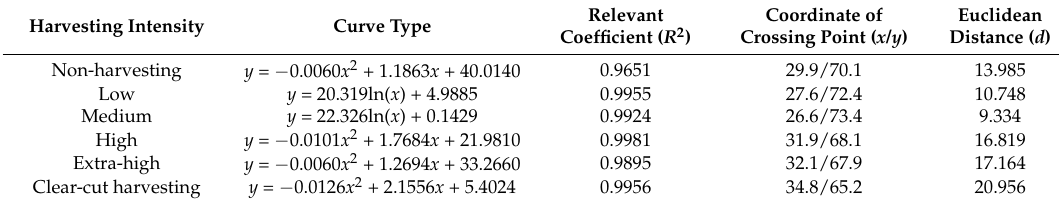
Table 8. Changes of plant community stability 15 years after different harvesting